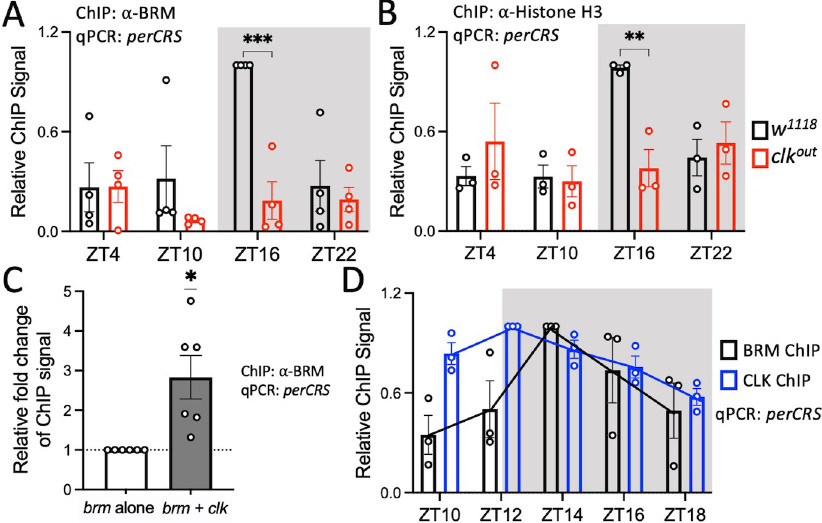
Fig 2. CLK promotes BRM occupancy at the per promoter. (A) BRM and (B) Histone H3 occupancy at the perCRS in head tissues of w 1118 (black) and clk out (red) flies (A: n = 4; w 1118 RAIN p = 0.0056, clk out RAIN p = 0.7915; B: n = 3; w 1118 RAIN p = 0.0488, clk out RAIN p = 0.2080). Each data point represents a biological replicate, and each biological is an average of at least 2 technical replicates of qPCR. Asterisks denote significant p-values: � p < 0.05, ��� p < 0.001. Error bars represent ± SEM. The grey background denotes the dark phase of the LD cycle. (C) BRM binding at the perCRS in S2 cell nuclear extracts expressing either brm alone (white) or brm co-expressed with clk (grey). Relative fold change of ChIP signal is calculated with amount of BRM binding in the brm alone condition equal to 1(n = 6). (D) BRM (black) and CLK (blue) occupancy at the perCRS in heads of w 1118 flies collected at the indicated time points on LD3 (n = 3; BRM ChIP: RAIN p = 0.0016, phase = ZT14; CLK ChIP: RAIN p = 6.17e-6, phase = ZT12; DODR p = 0.0033). Trendlines connect the mean relative ChIP signal of each time